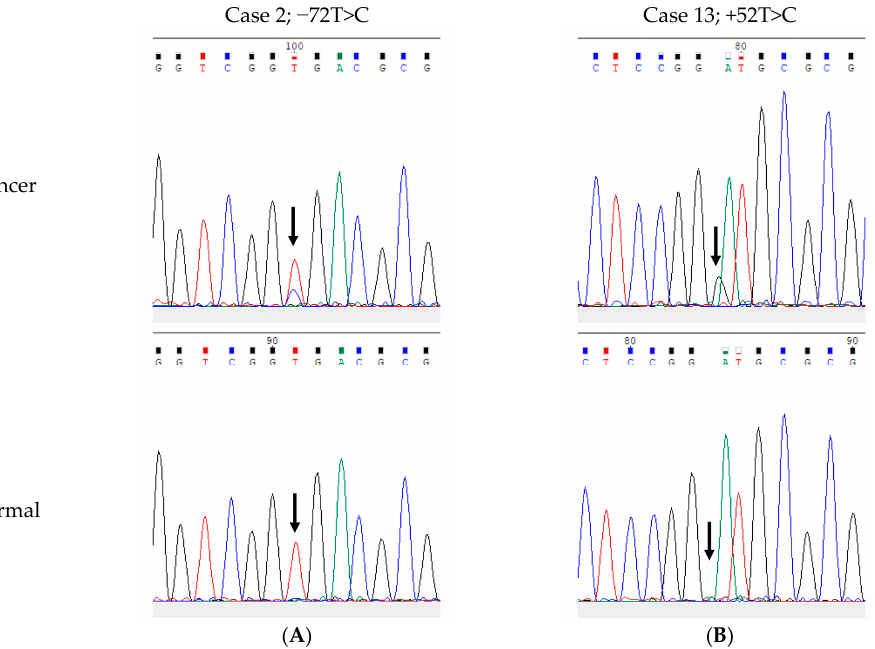
Figure 5. Electropherograms of representative somatic single-nucleotide variants (SNV) in the rDNA promoter region in corresponding cancer tissue (upper panel) and normal tissue (lower panel). ( A ) SNV − 72T>C in case 2 and ( B ) +52A>G in case 13. Note that there was no apparent additional peak at +49 in both cancer and normal tissues in this case, suggesting that Case 1 harbored +49 germline SNV.